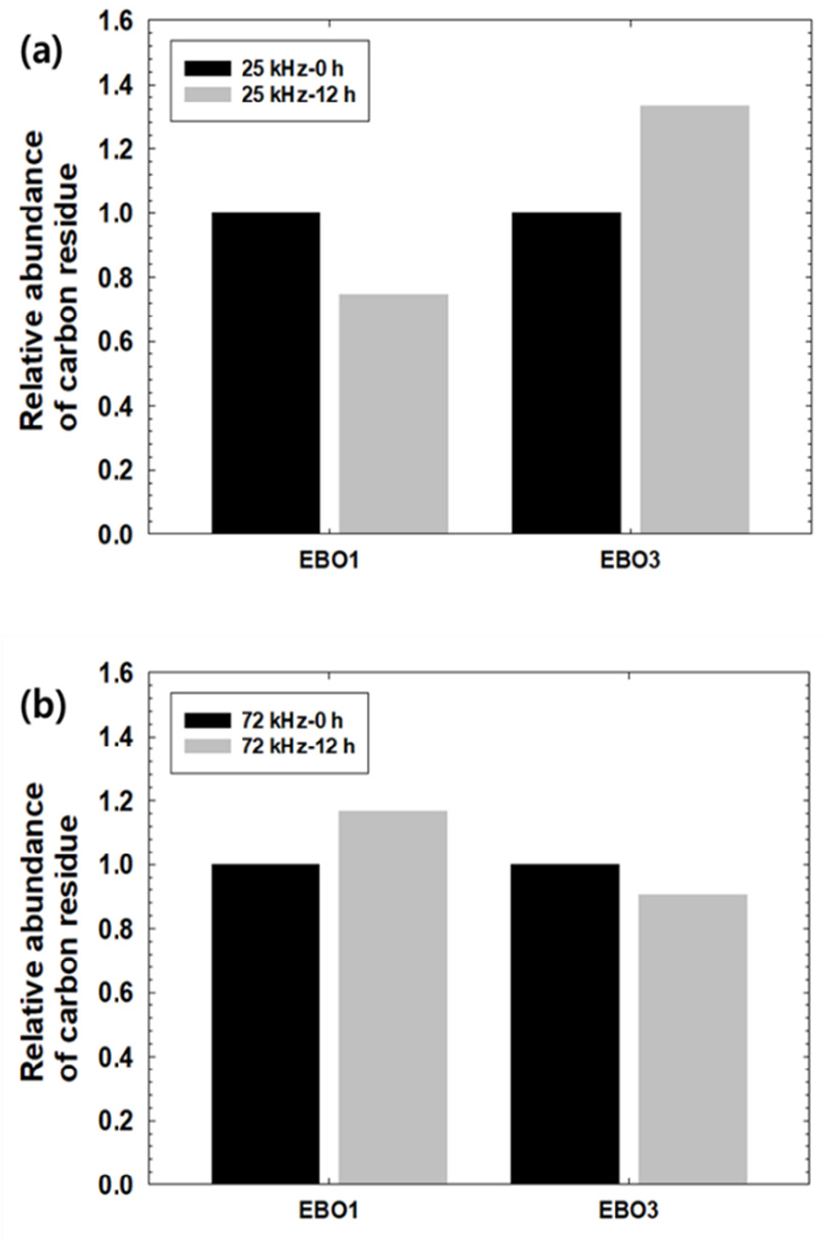
Figure 2. Change in carbon residue over 12 h in EBO1 and EBO3 at frequencies of ( a ) 25 kHz and ( b ) 72 kHz.